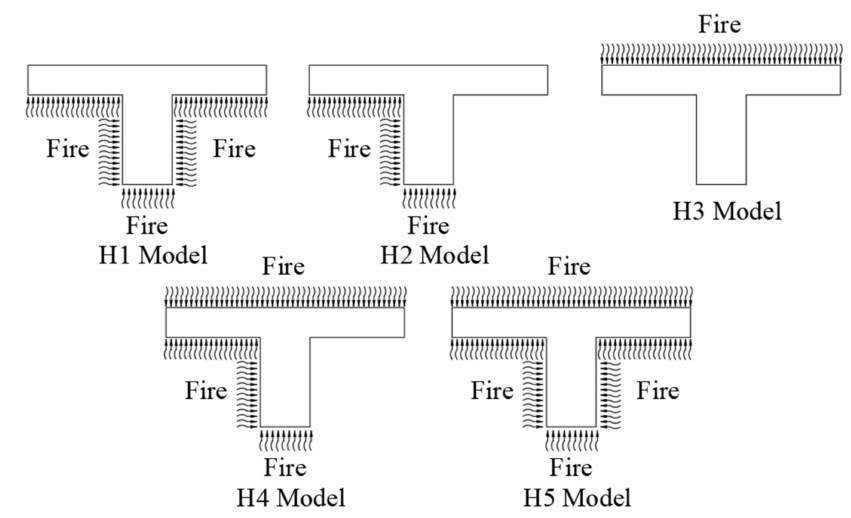
Figure 8. Fire pattern of prestressed concrete